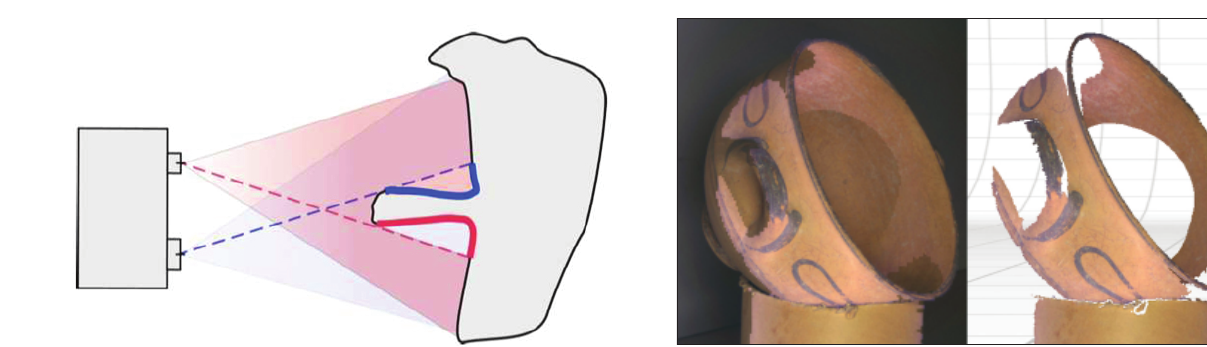
Figure 7. Portions which cannot be viewed simultaneously by emitter and receiver sensors